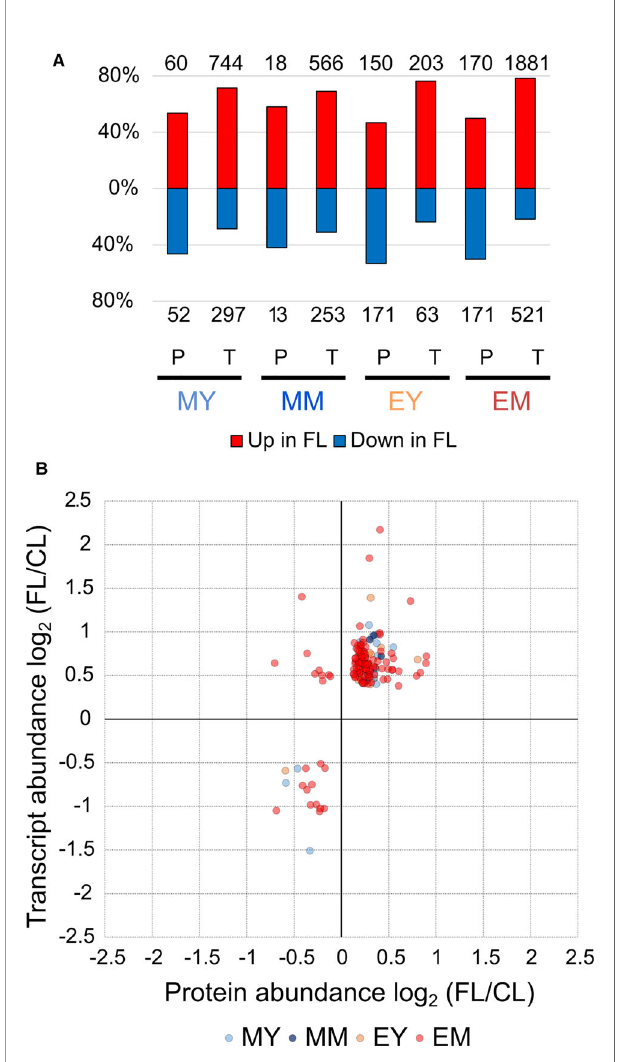
FIGURE 5 | Comparison of the FL response on the protein and transcript levels. (A) Percentage of signi fi cant increase or decrease in protein and transcript abundance in FL. Numbers above and below the bars show absolute numbers of proteins/transcripts found in each sample. (B) Quantitative correlation between signi fi cant changes in protein and transcript abundance. Twenty proteins/genes were signi fi cantly changed in MY, 5 in MM, 14 in EY, and 123 in